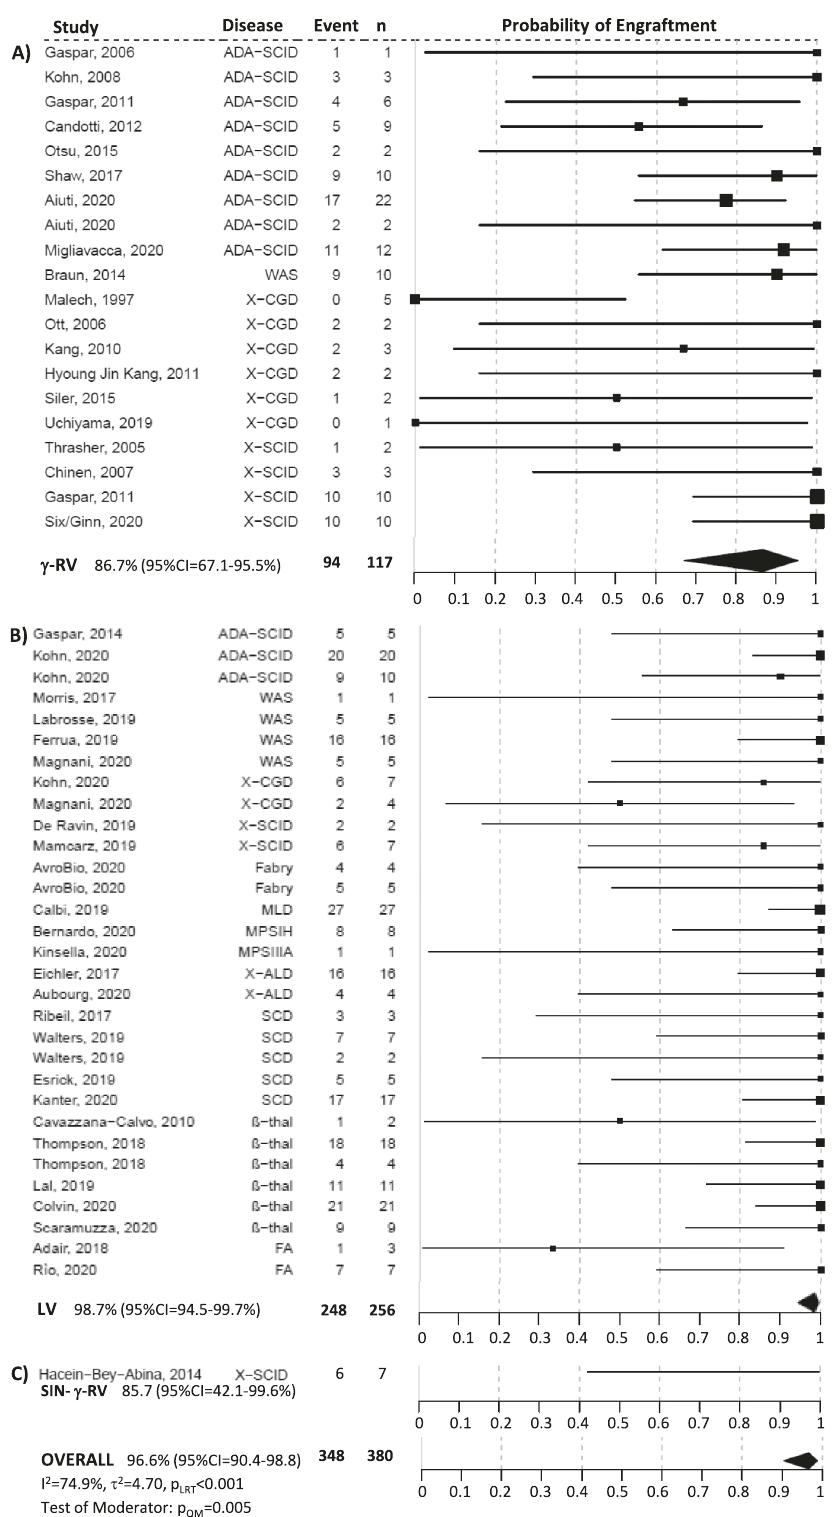
Fig. 5 Forest plot of the rate of engraftment by vector type, i.e., (A) γ RV, (B) LV, (C) SIN- γ RV, and overall. The squares indicate the rate of engraftment and their size re fl ects the study sample size, while the horizontal lines represent 95% Con fi dence Intervals (CI). The diamond denotes the summary effect size from the random-effects model for all or subgroups of studies (from a meta-regression model), and the width of the diamond depicts the overall 95% CI. The indices of heterogeneity (I 2 and τ 2 ) refer to the overall analysis or to the single subgroups, and p LRT is the p value for the test of residual heterogeneity, while p QM refers to the test on vector type as moderator. All tests were two-tailed. Source data are provided as a Source Data fi